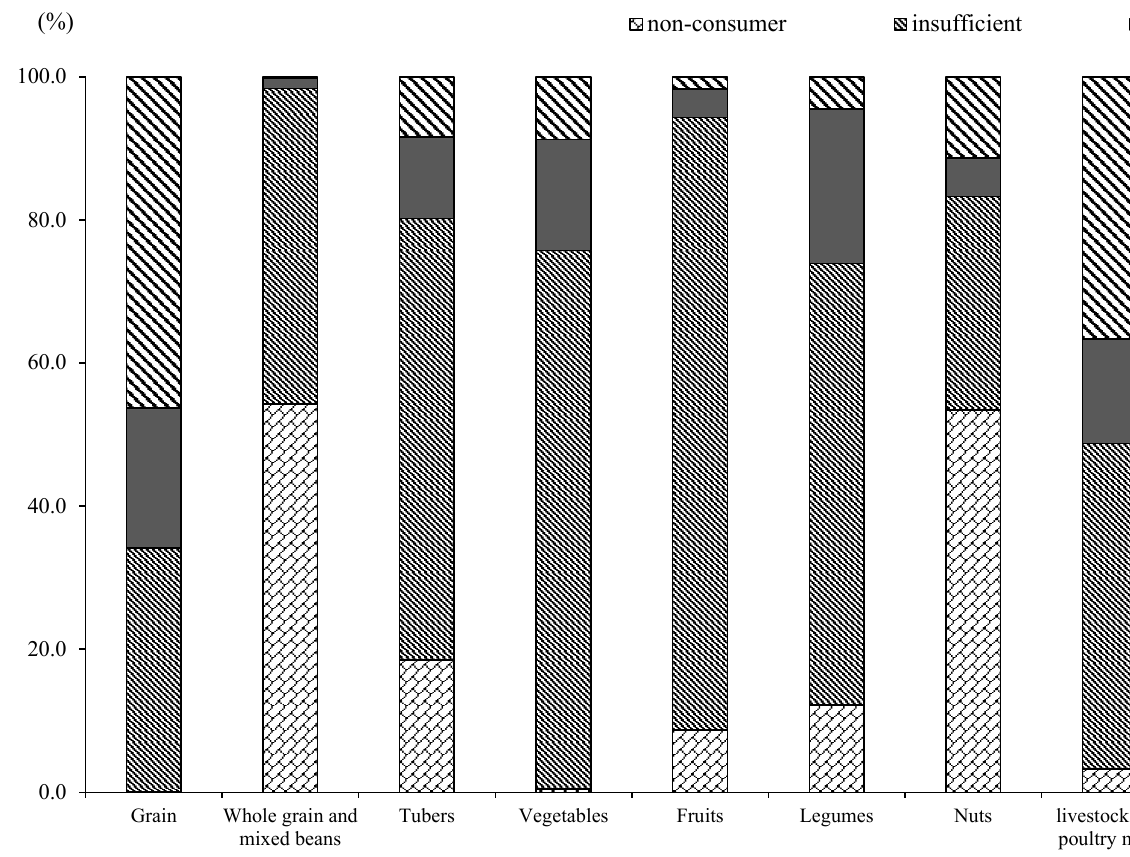
Figure 1. Comparisons of daily food intakes and recommendations among Chinese adults aged 55 years and above in four provinces in 2020.